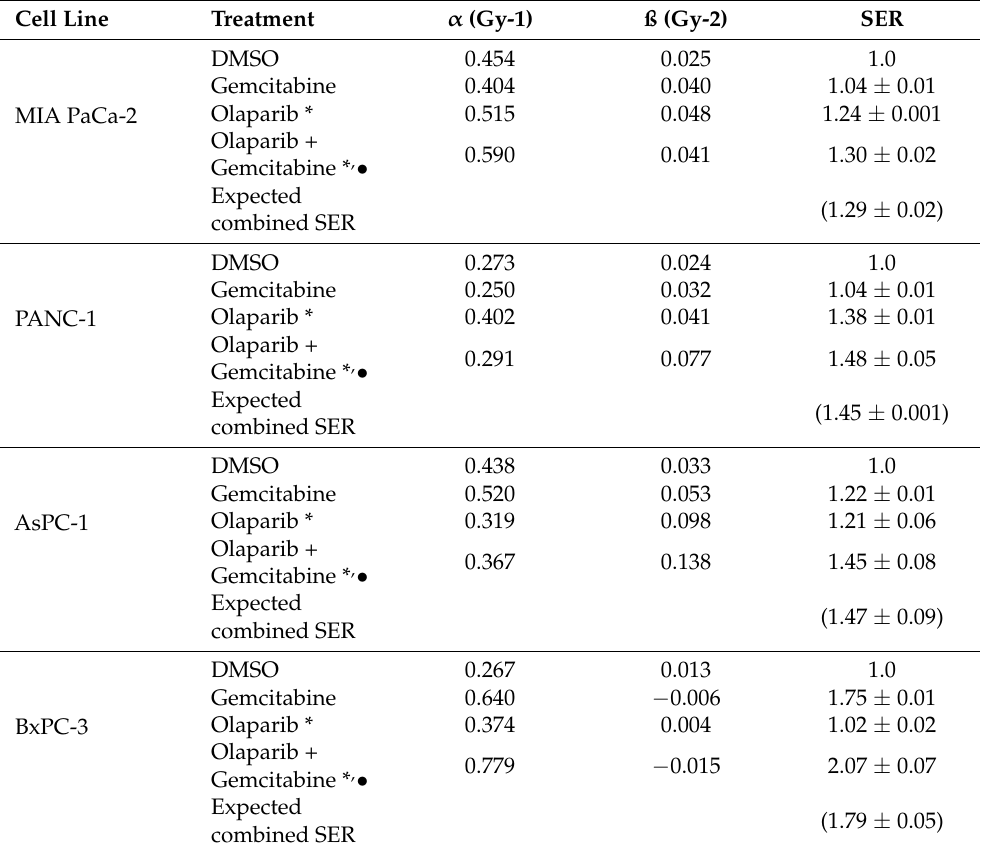
Table 2. Values of linear quadratic parameters ( α and ß) and standard enhancement ratio (SER) from PDAC cells treated with ionizing radiation and olaparib and/or gemcitabine. Statistical significance is indicated: * p < 0.05 (vs. control). • p < 0.05 (vs. Gemcitabine).